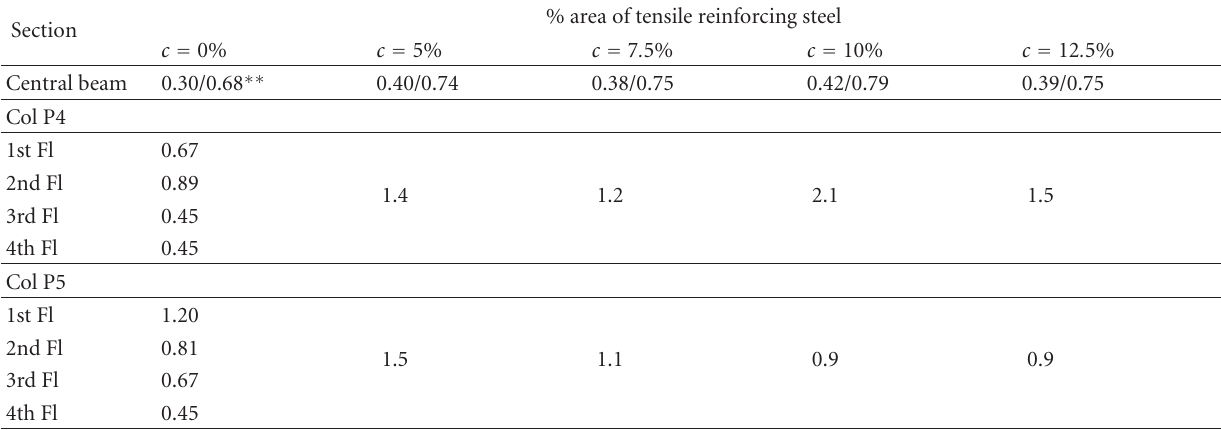
Table 2: Reinforcing steel in the design of the central frame of the prototype building in Figure 3 designed to di ff erent proportions of lateral load ( c